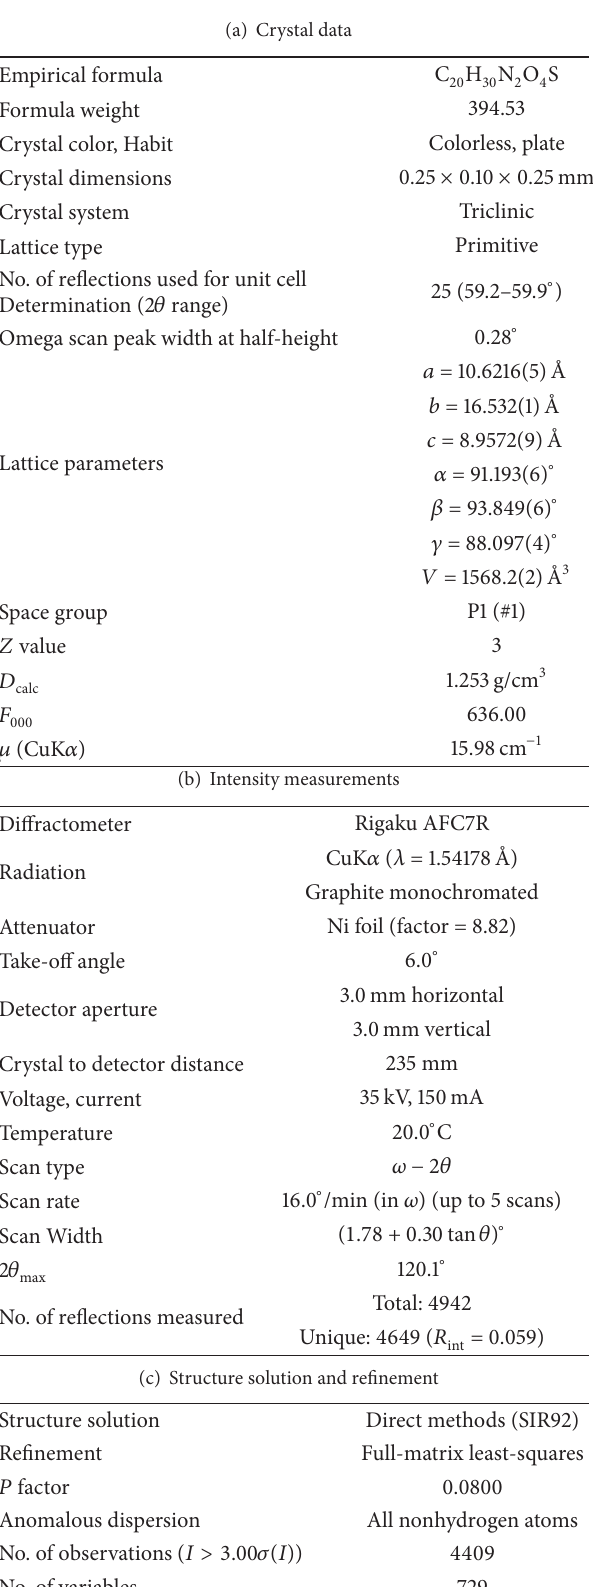
Table 1: Summary of crystal data, intensity data collection, and structure refinement for compound 3 at 20.0 ∘